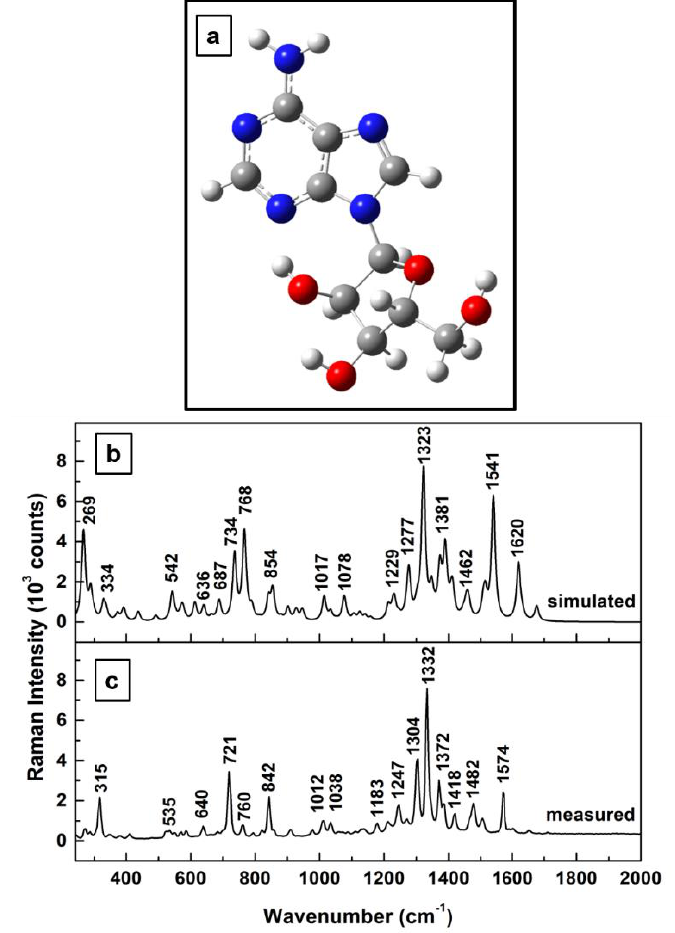
Figure 1. ( a ) Adenosine structural representation in neutral state after energy optimization. Red and blue colors were used for oxygen and nitrogen atoms, respectively. ( b , c ) theoretically calculated and experimentally measured Raman vibrations of adenosine, respectively. The Raman spectrum was recorded for the standard adenosine powder.